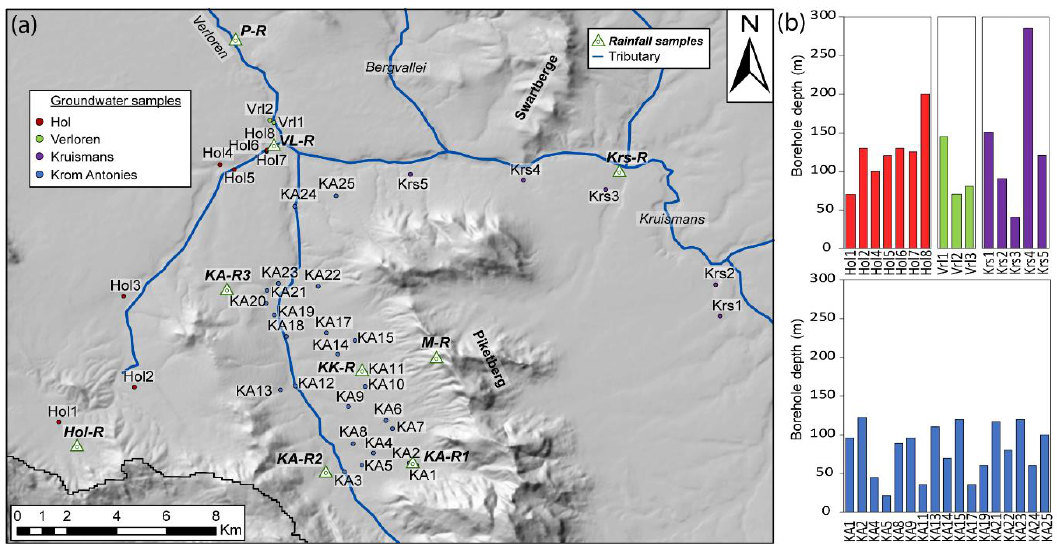
Figure 3. ( a ) Groundwater and precipitation station sample locations with ( b ) average borehole depths for boreholes where depth could be determined within the catchment. Note that precipitation was only collected from locations KA-R2, KK-R and VL-R. All other locations had incomplete precipitation collections records.